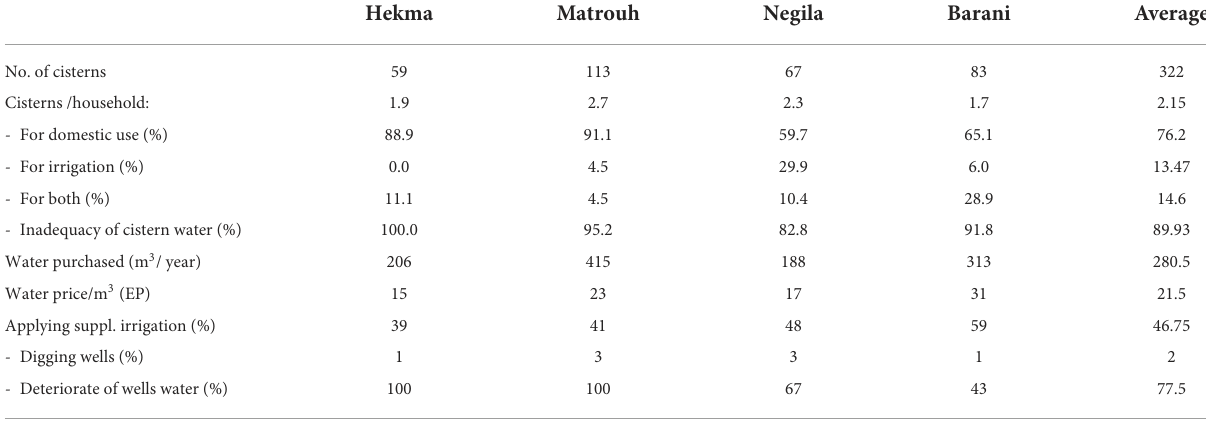
TABLE 2 Water sources and irrigation for